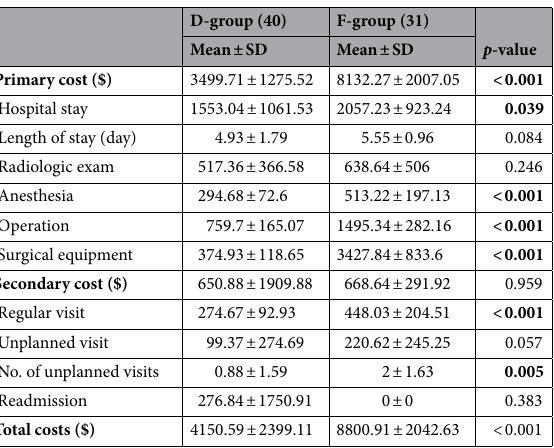
Table 3. Comparison of cost. SD standard deviation. Boldface type indicates statistical significance.